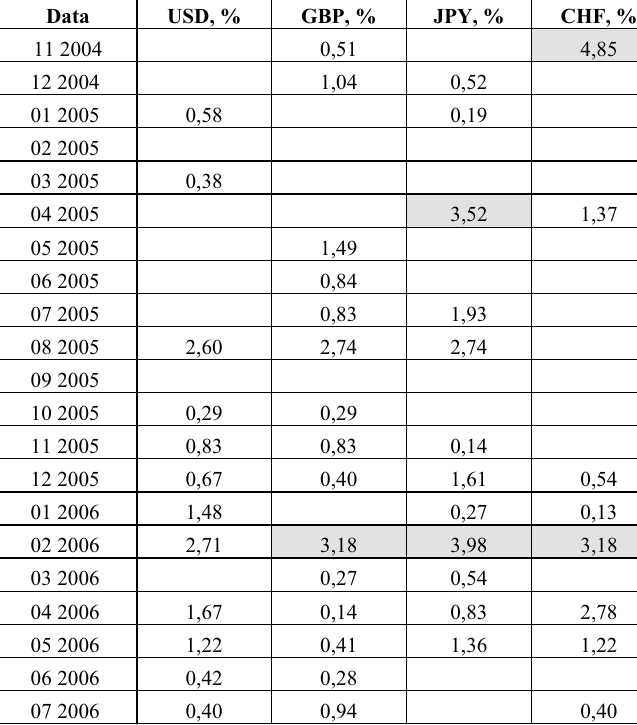
Table 2. VaR model back-testing results